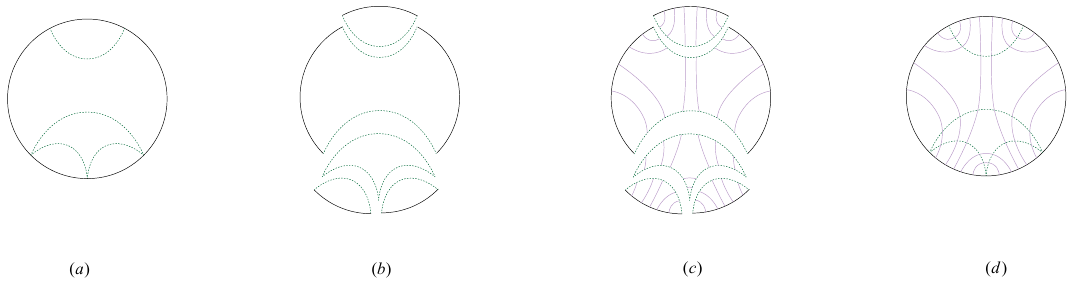
Figure 2 . Bulk-cell decomposition method (where the mauve lines represent bit threads and the green dashed lines represent RT surfaces): (a) A specified set of non-crossing boundary regions corresponds to a set of non-intersecting RT surfaces; (b) Utilize the series of RT surfaces to discretize the bulk spacetime; (c) Regarding each cell as an individual spacetime, one can always find a locking thread configuration to lock all boundaries of each cell spacetime simultaneously; (d) Finally, by gluing all the locking thread configurations of cell spacetimes together, one can obtain a locking thread configuration of a whole bulk spacetime, and thus prove the